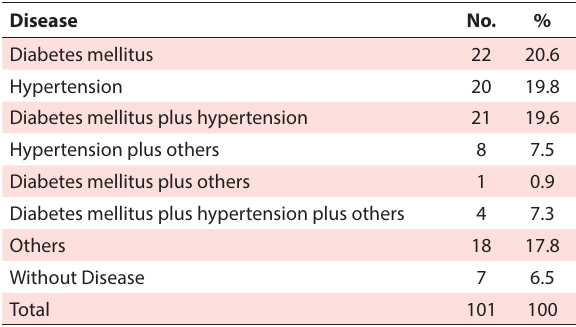
Table 2. Frequency of disease